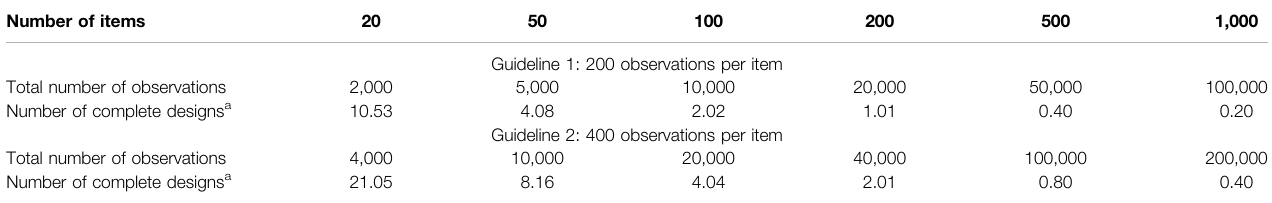
TABLE 1 | Total number of observations and number of complete designs according to the translated guideline for the BTL model for different numbers of